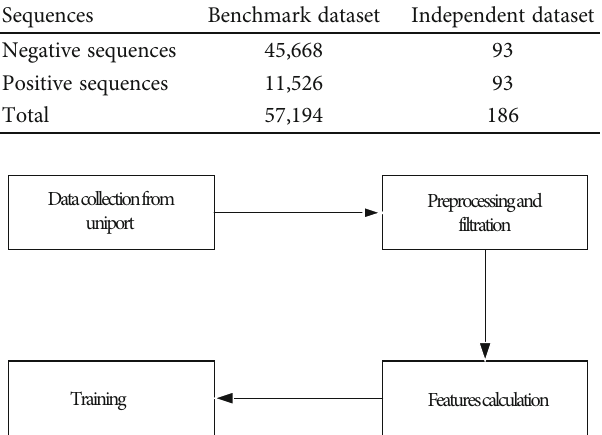
Figure 2: Flowchart of the proposed